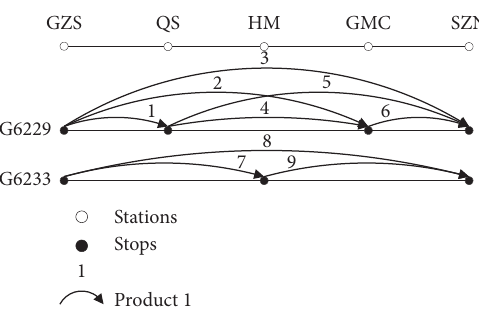
Figure 3: The relationship between trains and ODs in small-scale instance.